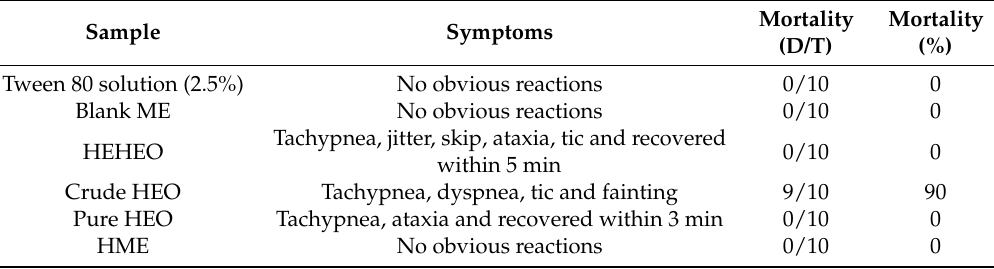
Table 5. Acute toxicities of HEHEO, crude HEO, pure HEO, and HME in mice. Mortality Mortality Sample Symptoms (D/T) (%) Tween 80 solution (2.5%) No obvious reactions 0/10 0 Blank ME No obvious reactions 0/10 0 Tachypnea, jitter, skip, ataxia, tic and recovered HEHEO 0/10 0 within 5 min Crude HEO Tachypnea, dyspnea, tic and fainting 9/10 90 Pure HEO Tachypnea, ataxia and recovered within 3 min 0/10 0 HME No obvious reactions 0/10 0 Note: D/T, Dead/Treated